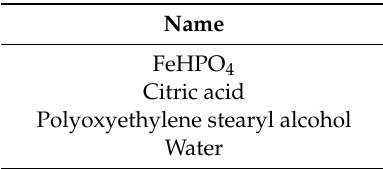
Table 1. Chemical composition of